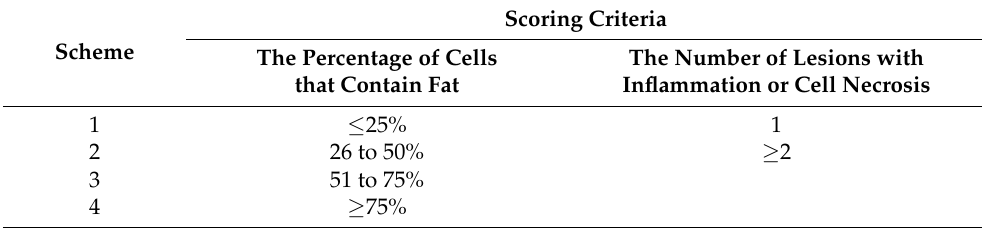
Table 1. The pathological score of the liver.